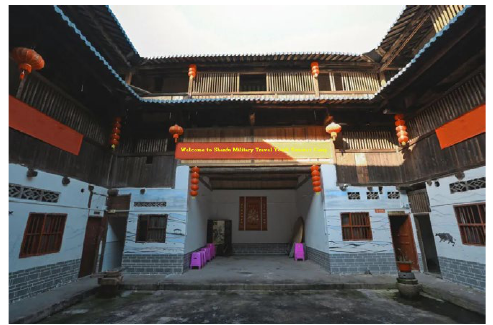
Figure 3. The Yude Building that has been transformed into a summer camp site.